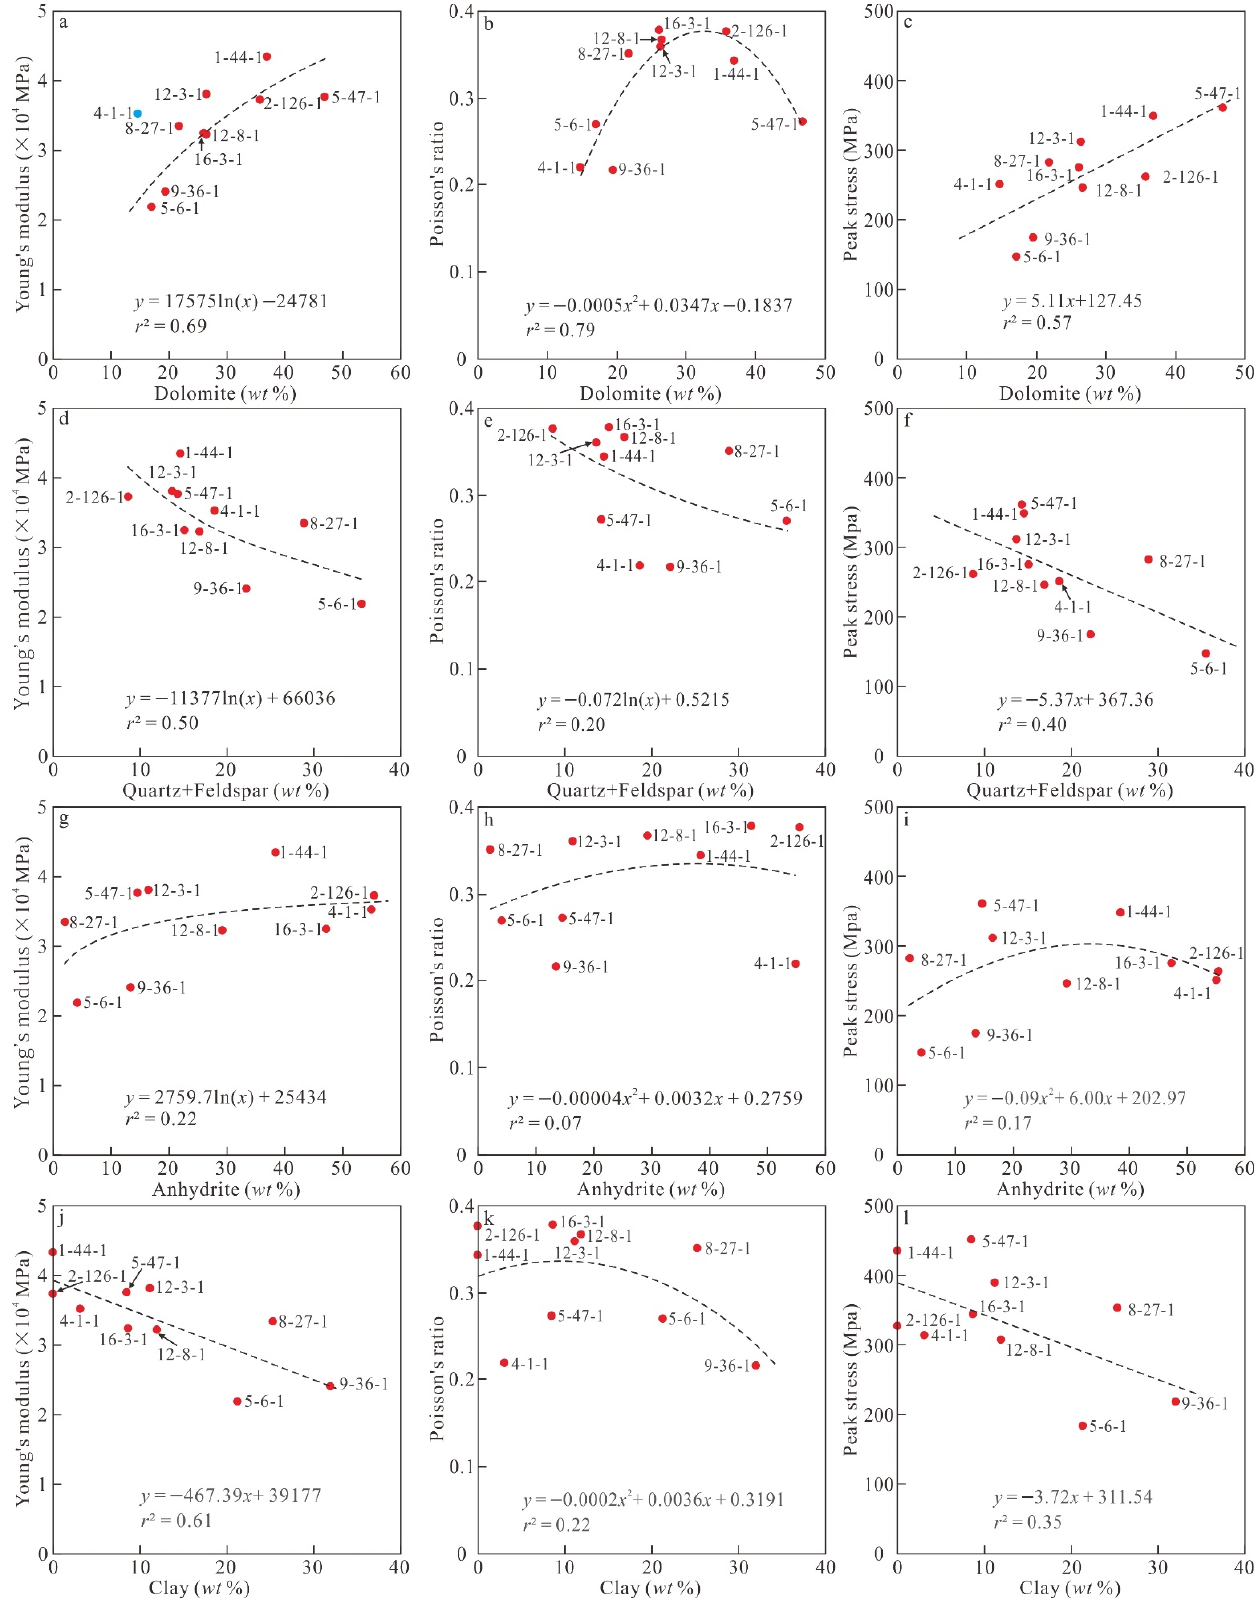
Figure 5. ( a–l ) Correlations between mineral content and mechanical properties. (The blue point in Figure 5a does not participate in the fitting.)